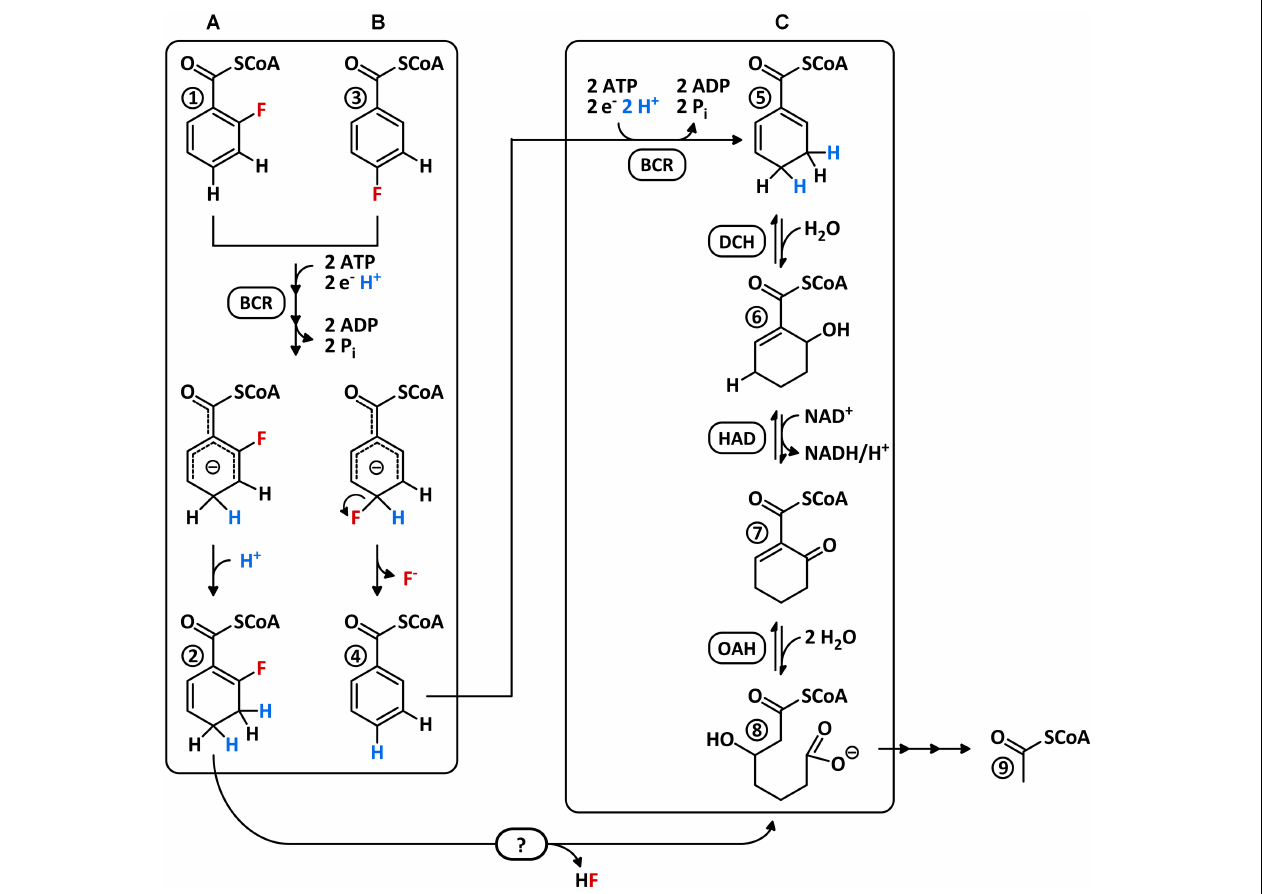
FIGURE 1 | Scenarios for the catabolism of 2- and 4-F-BzCoA via the BzCoA degradation pathway. Putative conversion of (A) 2-F-BzCoA to F-1,5-dienoyl-CoA and (B) experimentally verified defluorination 4-F-BzCoA to BzCoA by class I BCR. Both compounds are suggested to be ATP-dependently reduced to a common anionic transition state, which is either protonated at C3/C5 to a 2- or 6-F-1,5-dienoyl-CoA (A) (only the 2-F-isomer is shown) or defluorinated to BzCoA (B) at the para -position. Direct defluorination of 2-F-BzCoA by BCR is unlikely as it would require protonation at C2 instead of C4. (C) BzCoA degradation pathway involving ATP-dependent BCR, DCH, HAD, and OAH. At the beginning of this study it was unknown how 2-F-BzCoA is channeled into the BzCoA degradation